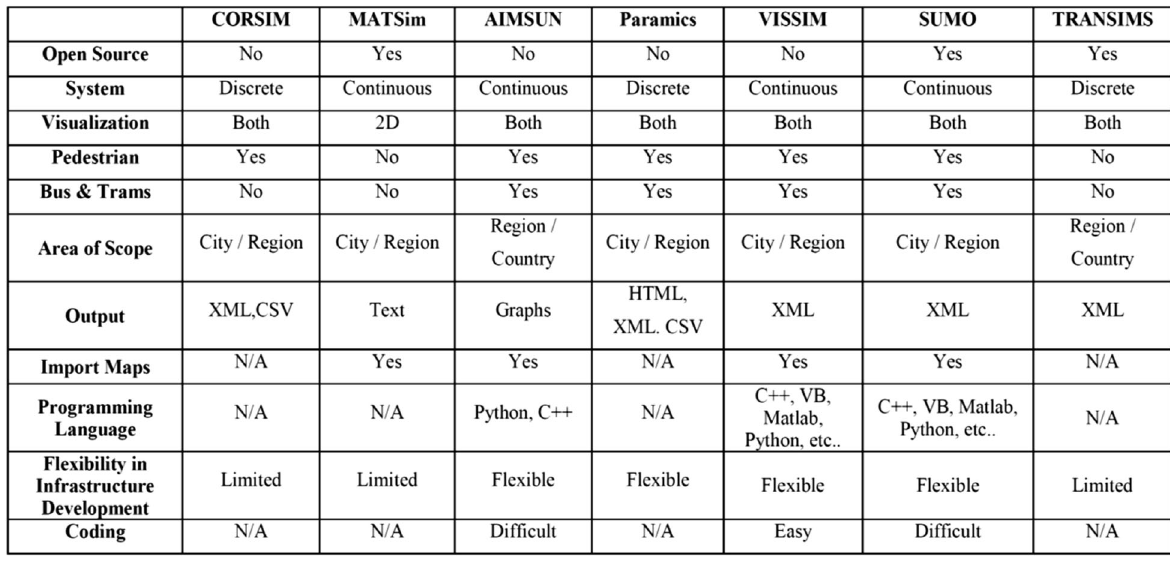
Table 3 Classification of most commonly used traffic microsimulation